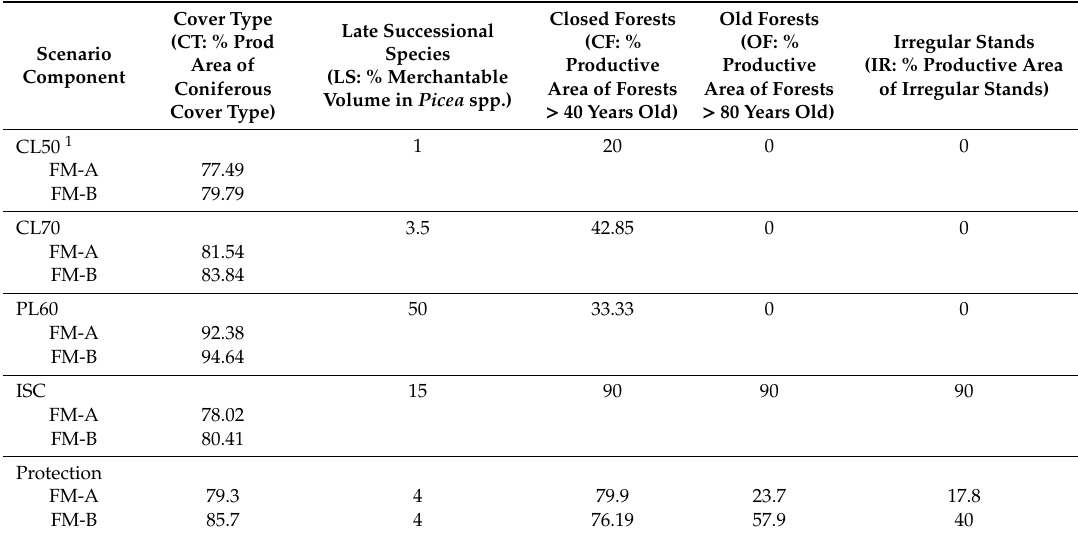
Table 3. Hypotheses used for each scenario